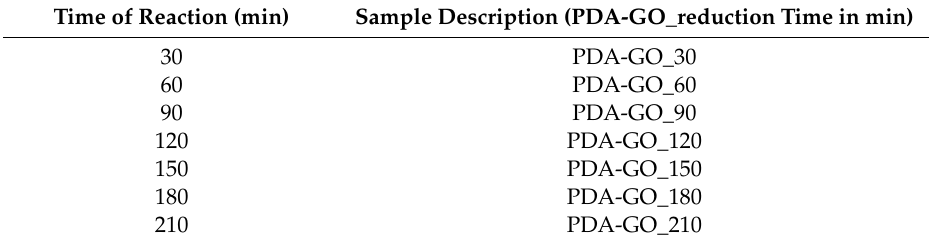
Table 1. Time of reaction between dopamine hydrochloride (DA) and graphene oxide (GO) and respective sample